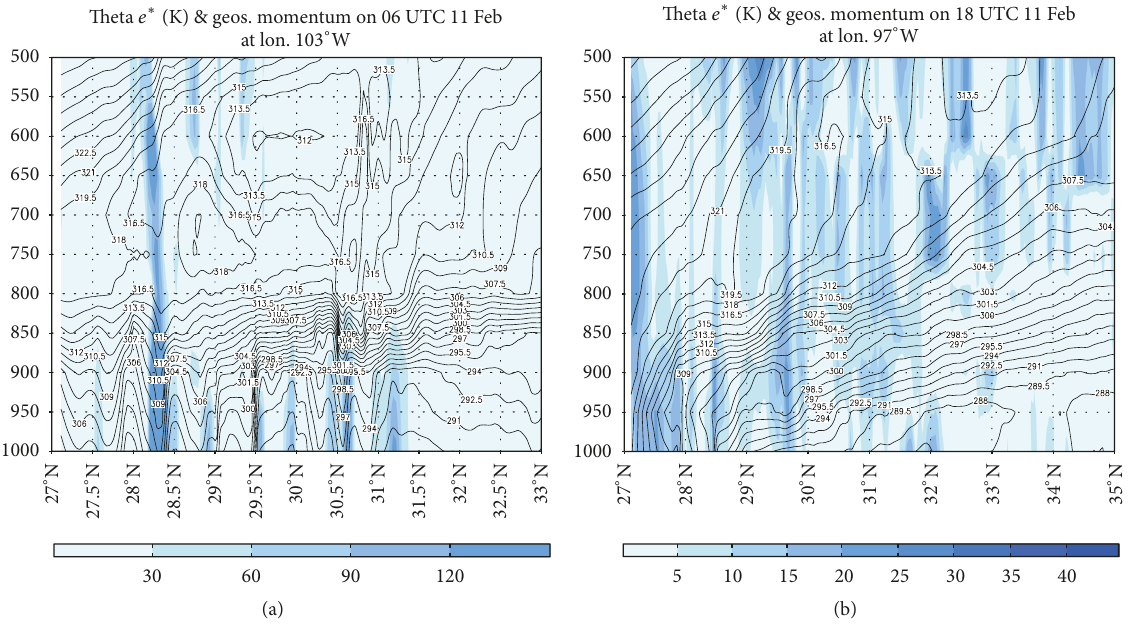
Figure 15: Simulated (4km) cross sections displaying theta- 𝑒 ∗ (K) and absolute geostrophic momentum (m s −1 ) at (a) 103 ∘ W on 0600 UTC 11 February and (b) 97 ∘ W on 1800 UTC 11 February 2010.